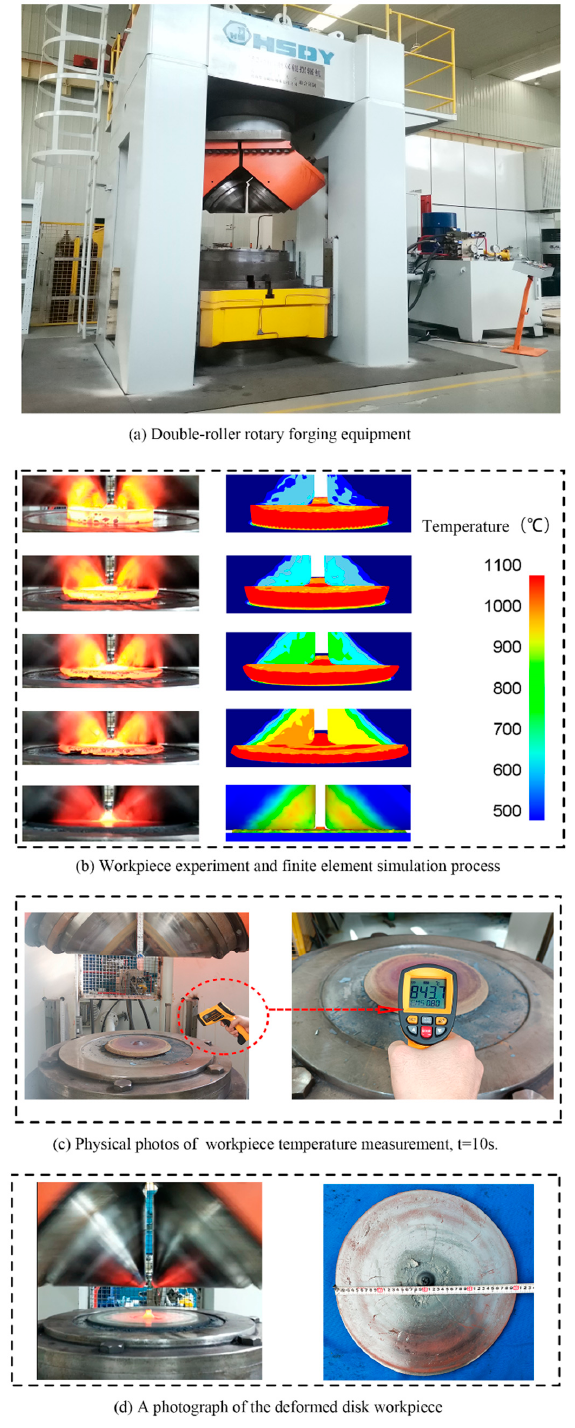
Figure 5. ( a ) Double-roller rotary forging equipment. ( b ) Disk workpiece experiment and numerical simulation process. ( c ) Physical photos of the workpiece temperature measurement, t = 10 s. ( d ) A photograph of the deformed disk workpiece.